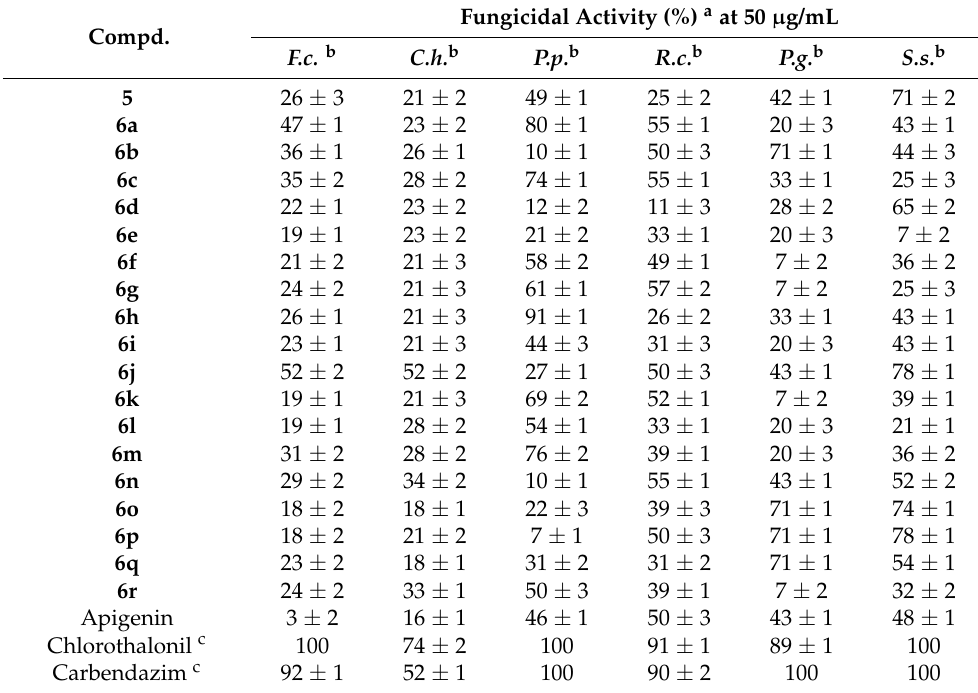
Table 2. In vitro fungicidal activities of compounds 5 and 6a – 6r against 6 kinds of fungi.